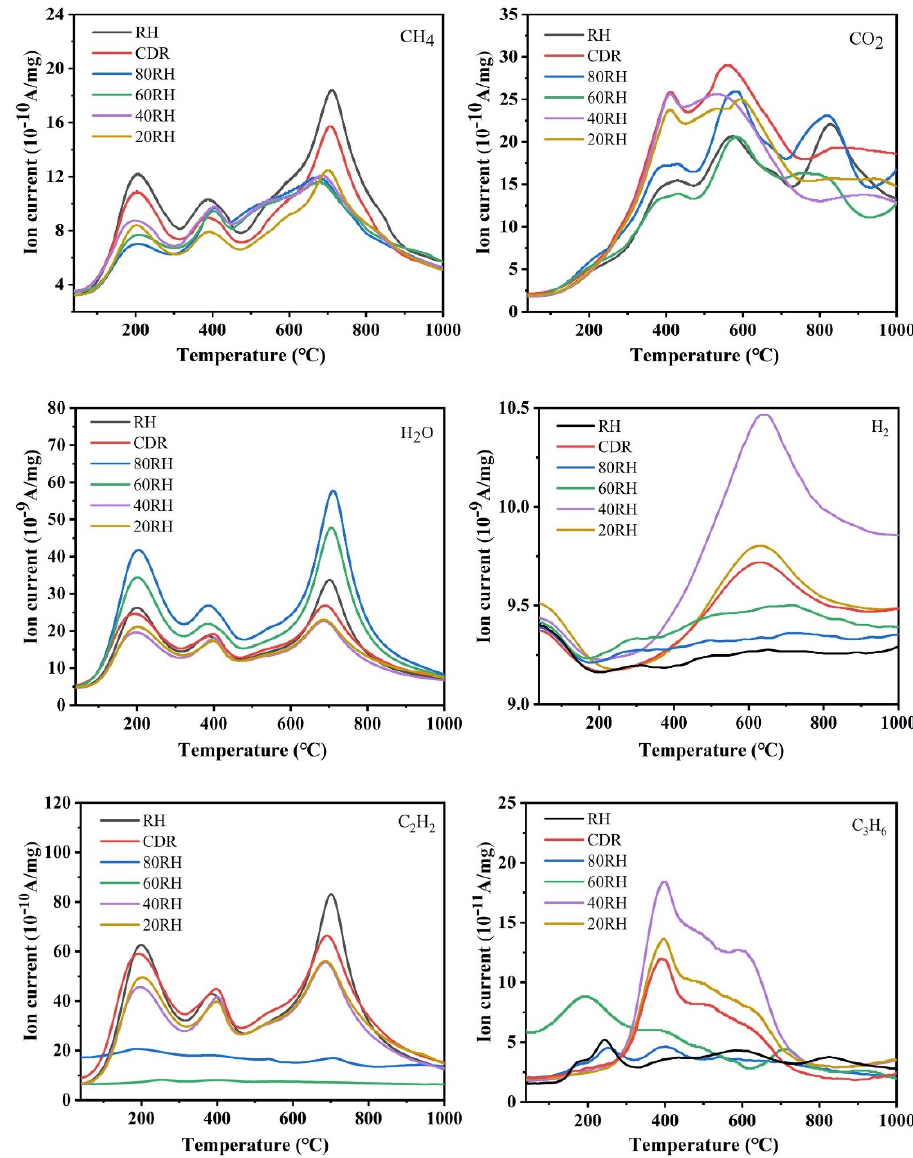
Figure 4. Gas emission curves during pyrolysis